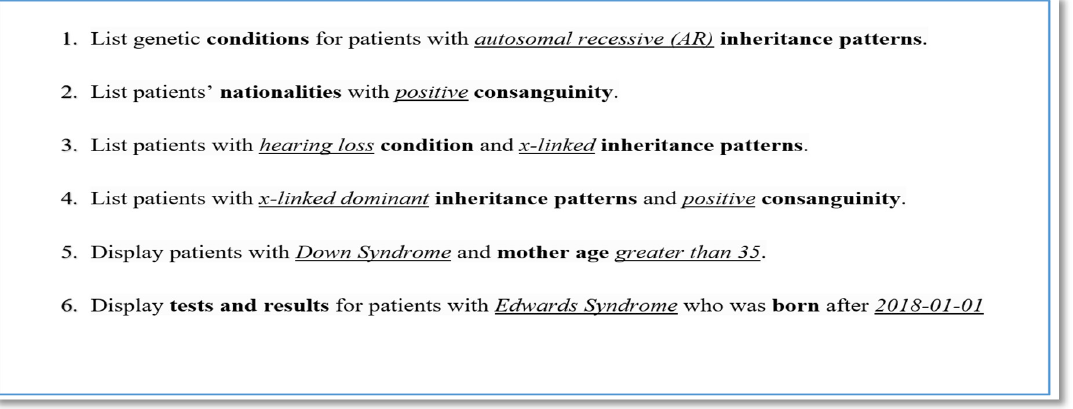
Figure 2. Query patterns represented in use cases.